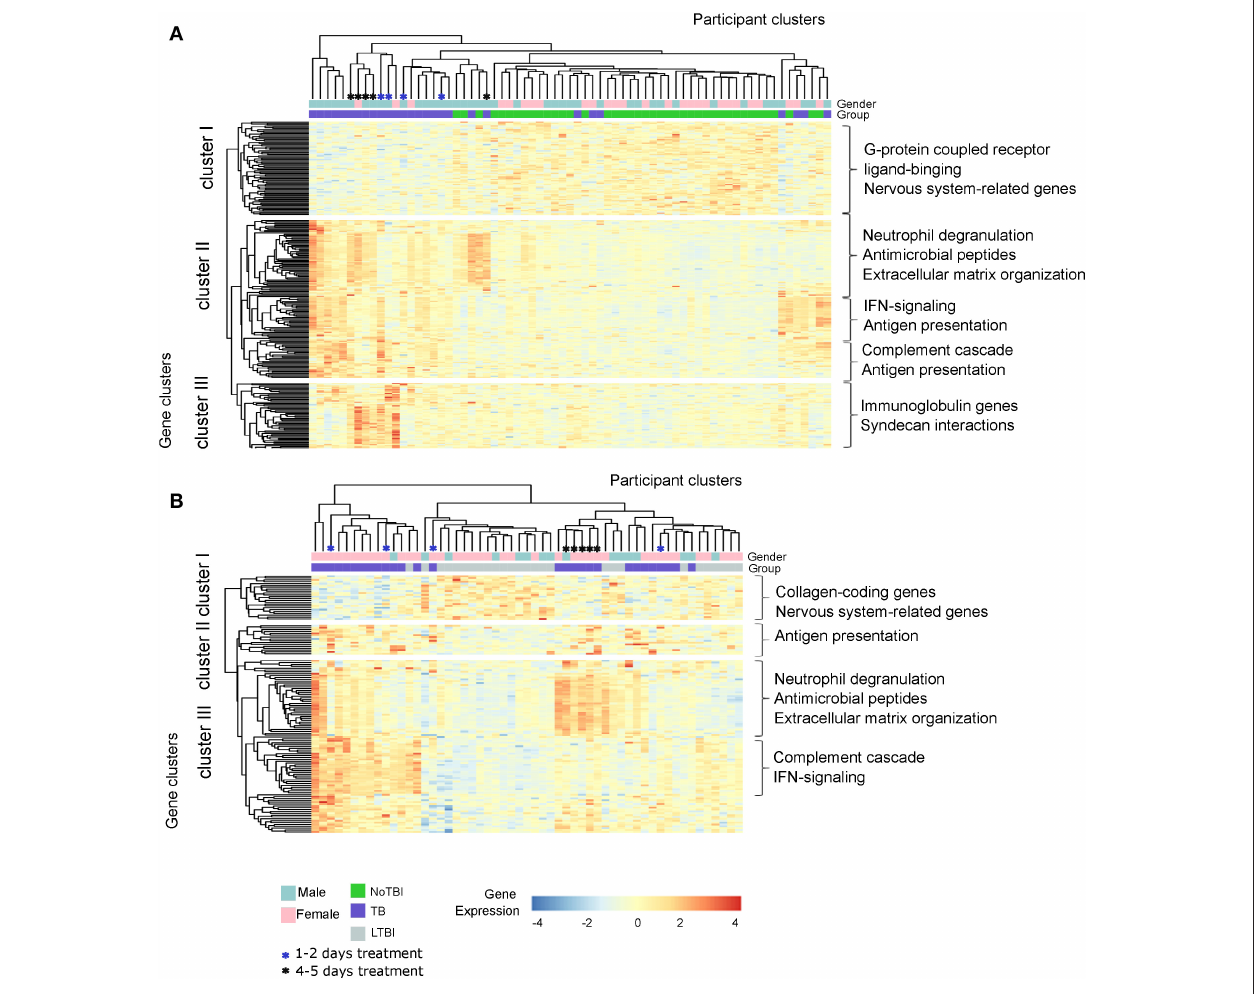
FIGURE 3 | Hierarchical Clustering analysis of the active TB patients and their contacts from the Spanish cohort based on the expression of the differentially expressed genes. (A) Heatmap based on the 259 DE genes between Active TB and NoTBI contacts. (B) Heatmap based on the 133 genes between active TB and LTBI contacts. Each column of the heatmaps represents one sample and each row represents one gene. Both the samples and the genes have been clustered based on the similarity of their expression pattern. The color of the cells indicates the expression of each gene for the corresponding sample. The main enriched pathways related to each gene cluster are